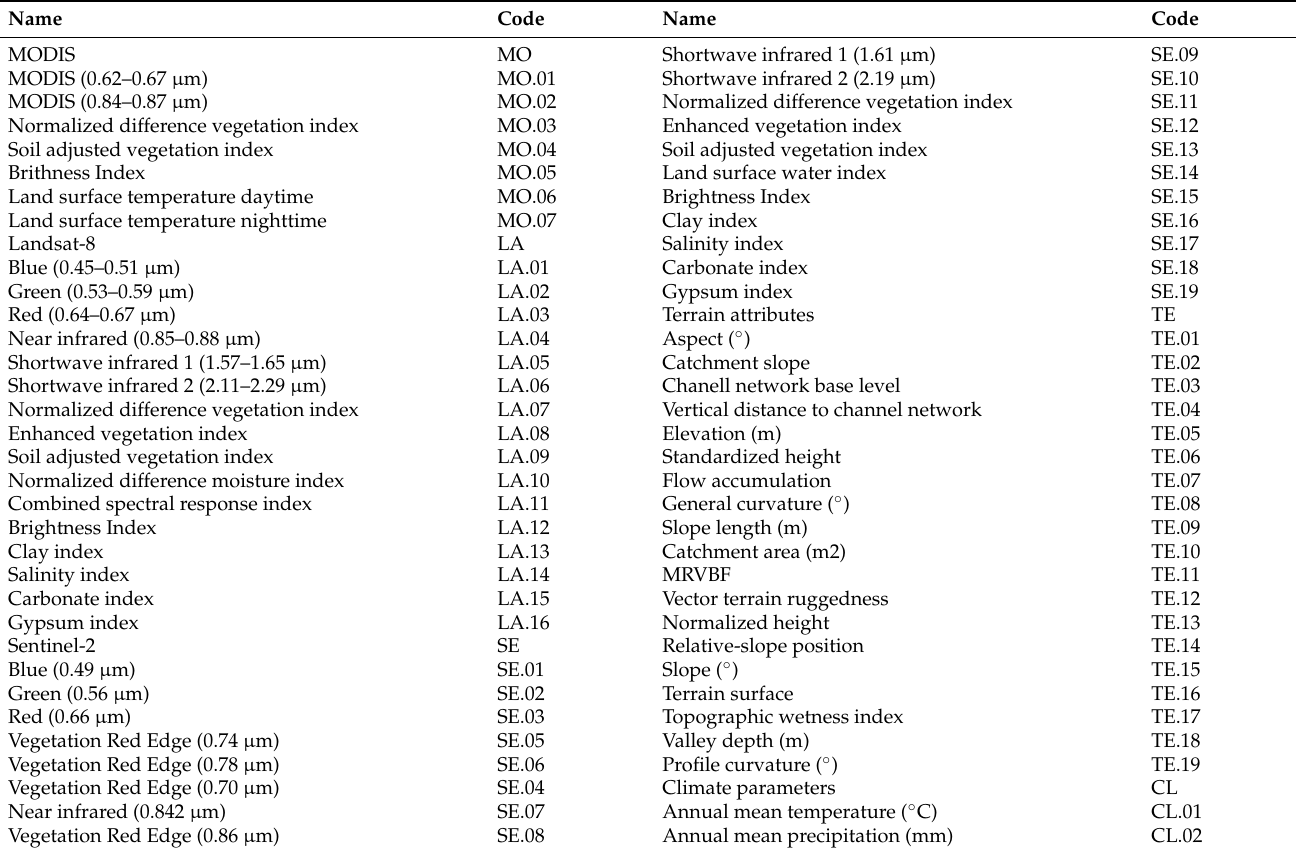
Table 2. Ancillary data are used for estimating soil properties (RS indices refer to Table